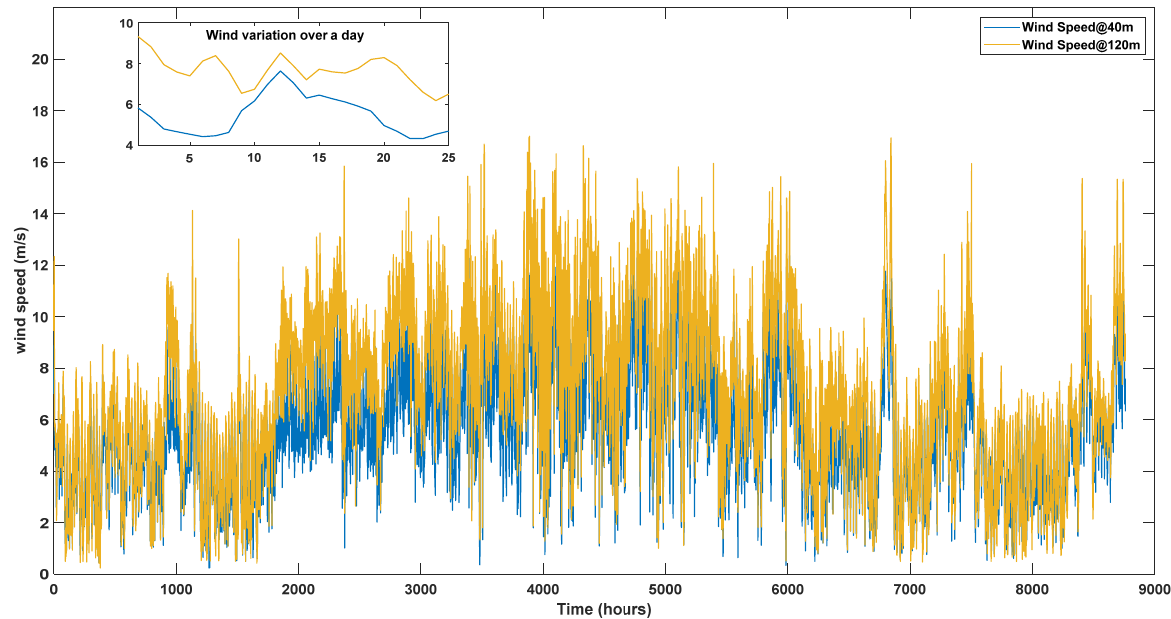
Figure 10. Wind profile at the proposed location at different elevations. The wind speeds at the proposed location are obtained from weather stations and are extrapolated to the required height using Equation (7). The power generated from the WECS can be obtained using Equation (8) [10]. Per the technical details of wind turbines provided in Section 3, a capacity use factor of ~40% can be achieved.